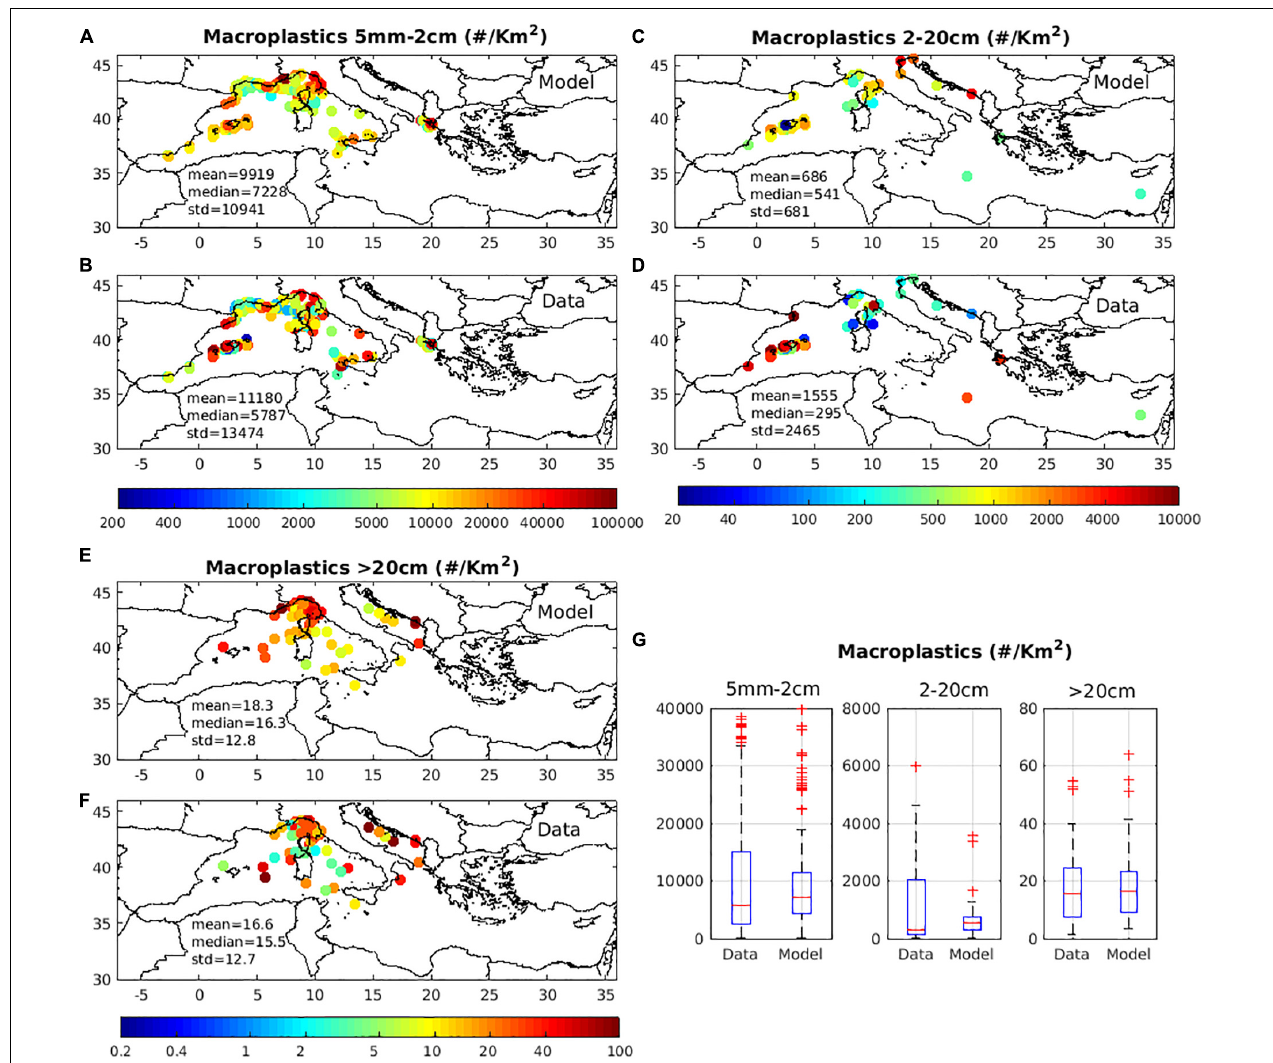
FIGURE 9 | Mean (2010–2017) model simulated concentration (#/Km 2 ) of (A) macroplastics 5 mm–2 cm, (C) macroplastics 2–20 cm, (E) macroplastics > 20 cm against available in situ data in (B,D,F) and boxplot showing model and data range, with median and 25th/75th percentiles indicated in (G) . In situ data were obtained from: Morris (1980); Aliani et al. (2003); Sánchez et al. (2013); Suaria and Aliani (2014); Arcangeli et al. (2015); Di-Méglio and Campana (2017); Fossi et al. (2017); Arcangeli et al. (2018); Campana et al. (2018); Ruiz-Orejón et al. (2018); Zeri et al. (2018); Constantino et al. (2019); de Haan et al. (2019); Palatinus et al. (2019); EMODnet